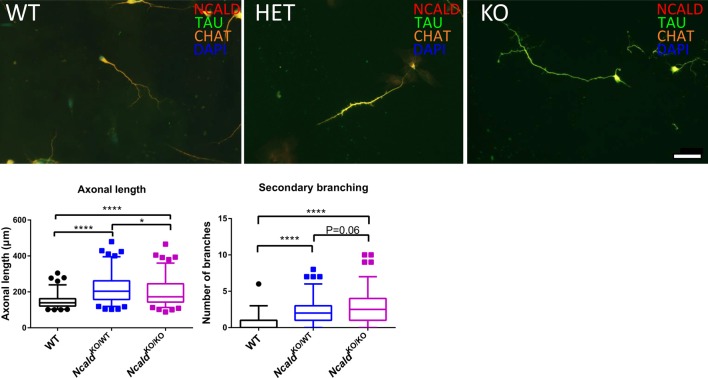
Heterozygous and homozygous Ncald deletion results in longer axons in spinal motor neurons (MNs). Cultured MNs isolated from WT, NcaldKO/WT and NcaldKO/KO E13.5 mouse embryos were stained with NCALD, TAU and Choline acetyltransferase (CHAT) antibodies. Nuclei were labeled with DAPI; scale bar 50 μm. Dot plot analysis reveals a statistically significant increase in the average axon length and secondary axonal branching in NcaldKO/WT and NcaldKO/KO neurons compared to WT; N = 108, 104, 105; ****P < 0.0001; *P < 0.05. Twenty-five to Seventy-five percent values covered by each box plot, line represents median and dotted outliers at <5% and >95% CI.